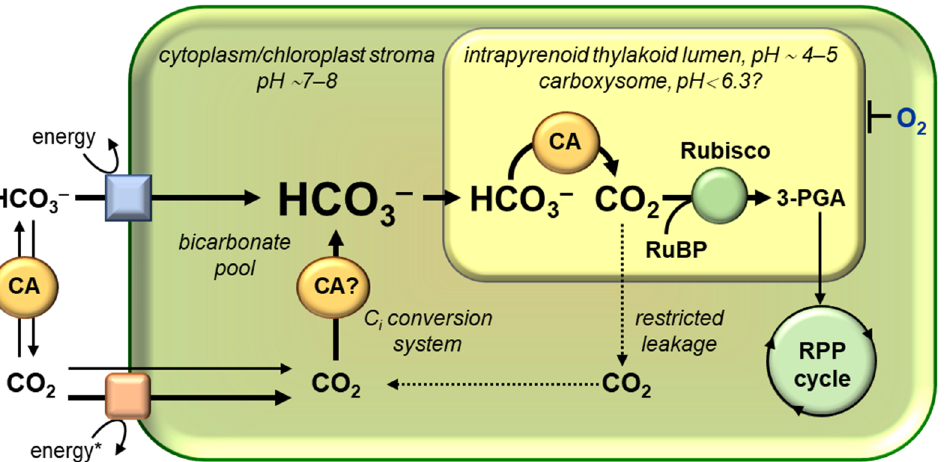
Figure 2. Schematic representation of the CCM in microalgal and cyanobacterial cells. The font size reflects the relative concentrations of CO 2 and HCO 3 − in the external environment and inside the cell. Thick arrows show the main direction of C i flow. * Energy requirements for the promoted CO 2 uptake are currently approved only for cyanobacteria.